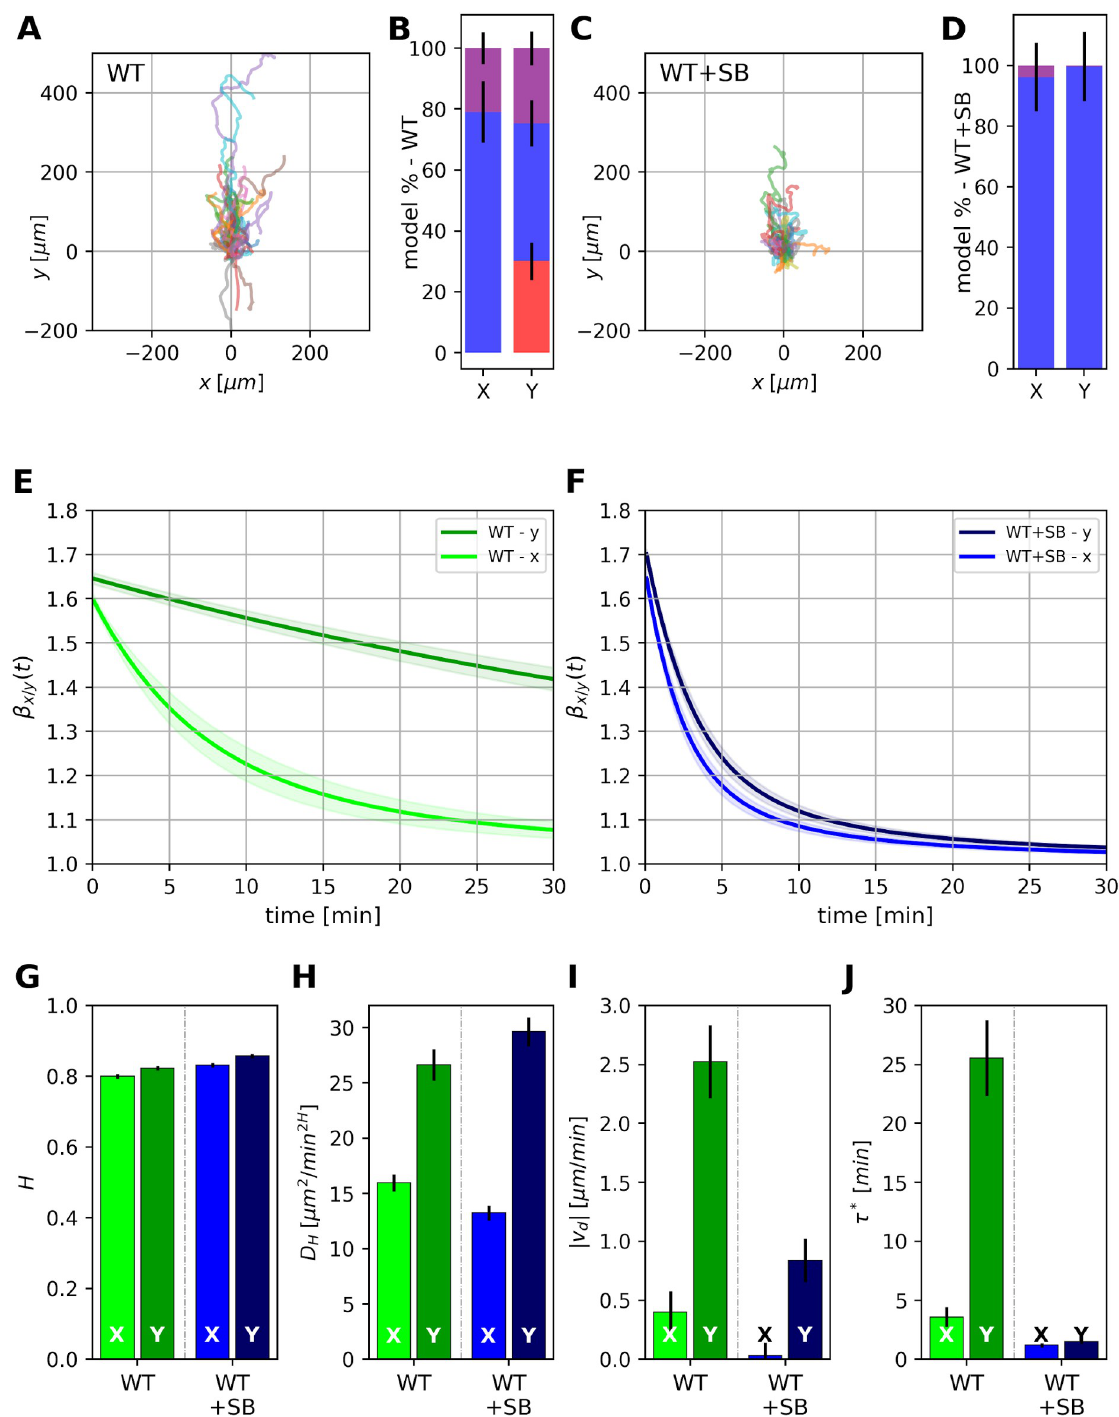
Fig 7. Model parameters for the dynamics of neutrophils in zebrafish larvae. (A) and (C) give an overview of all different trajectories of neutrophils moving in zebrafish larvae. Paths of neutrophils have different lengths. Neutrophils treated with blocker SB225002 (marked as WT+SB) have a reduced drift (C) compared to untreated cells (A). Model probabilities for WT neutrophils (B) and for the WT+SB group favor the exponentially tempered model under all directions and conditions (color coding as in Fig 4). (E) and (F) show the temporal behavior of the logarithmic derivative β ( t ) of the mean squared displacement for the two cell groups. WT+SB neutrophils are tempered much more strongly than WT neutrophils. The movement of WT neutrophils in parallel to the direction of chemotaxis ( y -direction) is only weakly tempered. (G)—(J) show the values of model parameter for fBm with exponential tempering: (G) Hurst exponent, (H) diffusion coefficient D H , (I) absolute value of drift v d , and (J) tempering time τ �